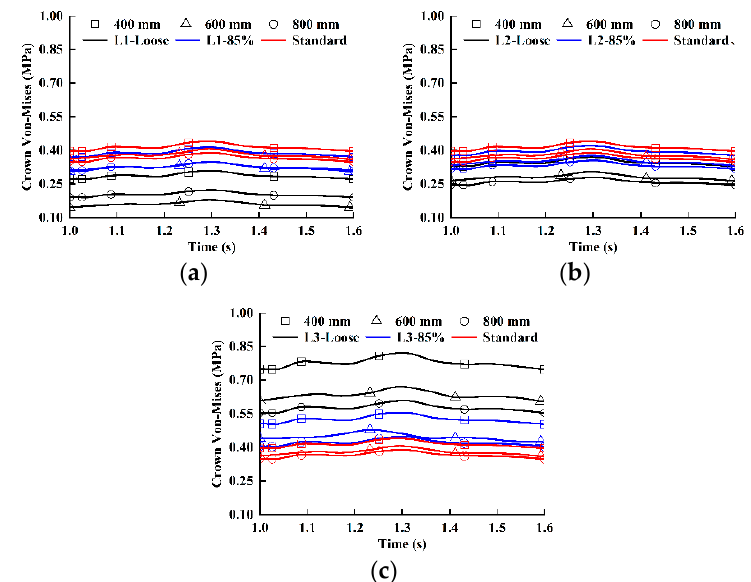
Figure 13. The crown Von-Mises stress of different diameter pipes under traffic load: ( a ) change in L1 compaction degree; ( b ) change in L2 compaction degree; ( c ) change in L3 compaction degree.